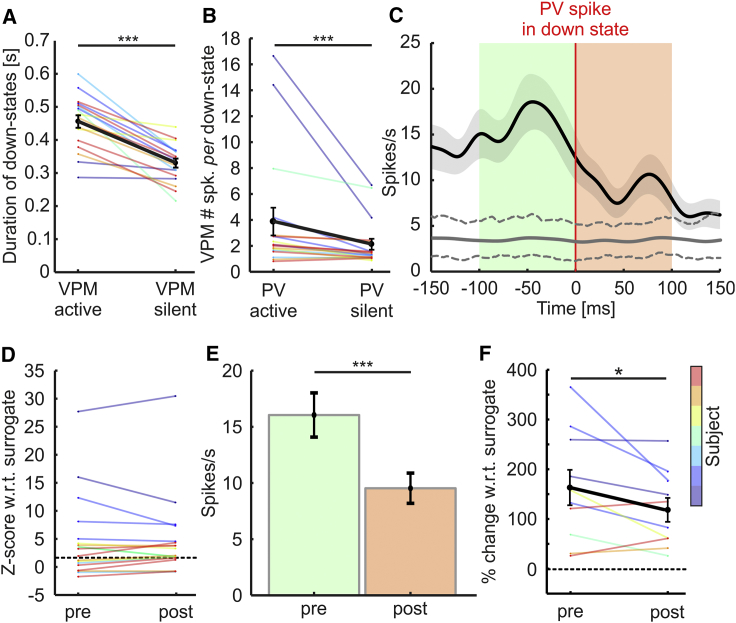
VPM Firing Correlates with Cortical Down-State Duration and PV Firing in Down States(A) Duration of cortical down states associated with detected VPM activity (VPM-active) and VPM inactivity (VPM-silent; p = 4.5E−7; one-tailed paired Student’s t test; n = 18 recordings from 7 animals).(B) VPM spike count in PV-active and PV-silent cortical down states (p = 2.5E−4; one-tailed Wilcoxon signed rank test; n = 18 cells in 7 animals).(C) Spike-triggered VPM IFR based on the timing of PV spikes recorded during cortical down states for one representative recording (Gaussian kernel SD, 12.5 ms; the thick black line indicates the mean; the shaded area the SEM). The VPM IFR triggered by “surrogate” spikes is displayed with the thick gray line. Dotted gray lines indicate the 5th and 95th percentiles of the distribution of the mean surrogate spike-triggered VPM IFR (100 surrogates).(D) Z scores in the pre- and post-time windows of the PV-spike-triggered VPM mean firing rate with respect to surrogate data: 10 out of 18 recordings showed a significant difference between actual and surrogate data in the pre-spike window (one-tailed z-test). The dashed line indicates significance at p = 0.05. Cells with Z scores corresponding to p > 0.05 lie above the dashed line and are marked with asterisks in Figure S2.(E) Mean firing rate of the VPM before and after PV spikes in down states (pre: [−100, 0] ms; post: [0, 100 ms]; mean ± SEM; p = 3E−4; two-sided Wilcoxon signed rank test; n = 116 spikes for the same recording as in C).(F) Variation of VPM mean firing rate relative to the overall mean surrogate firing rate in the pre- and post- windows (p = 0.032; one-tailed Student’s t test; n = 10 cells from 6 animals) for those cells showing a firing rate significantly higher than that of the surrogate data.See also Figure S2.